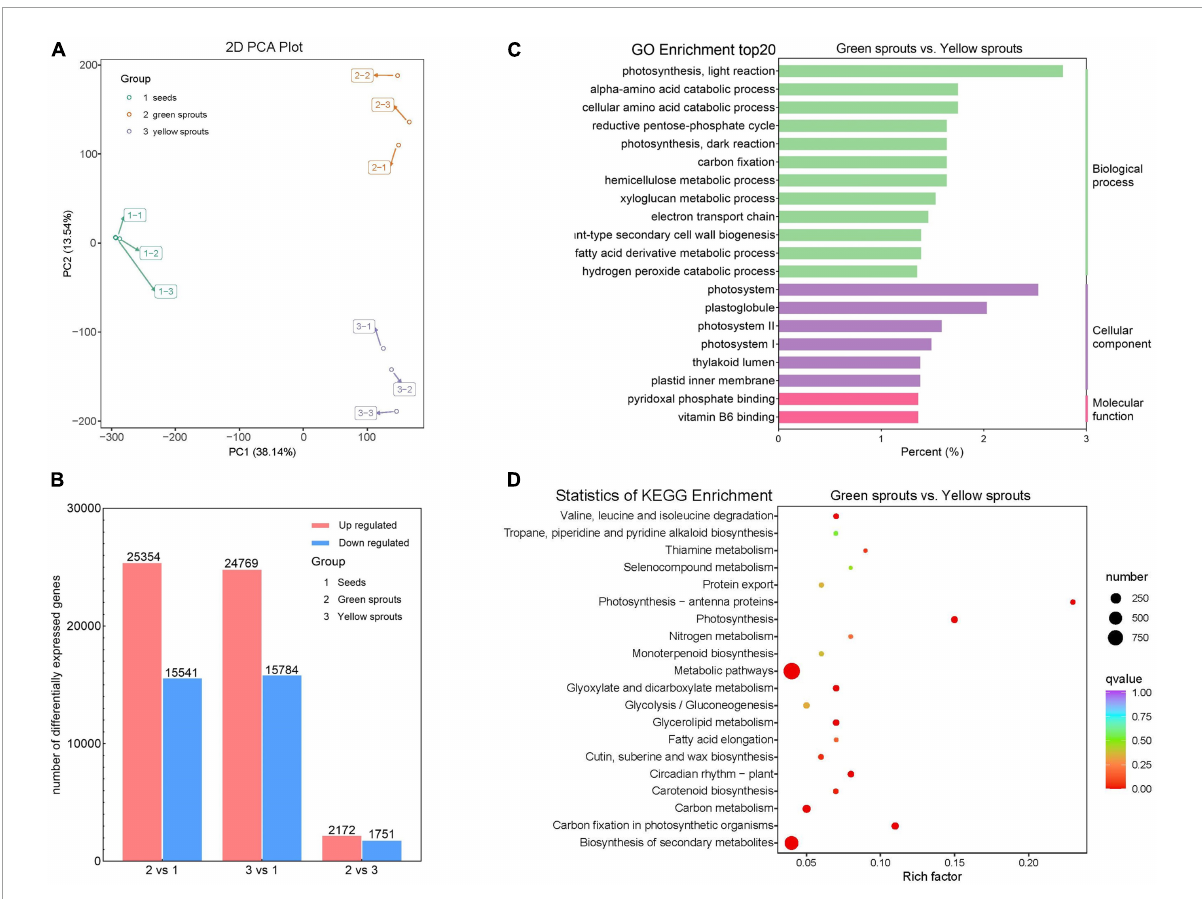
FIGURE2 Transcriptomic analysis of alfalfa sprouts. (A) PCA score plot of transcriptome profiles from different treatment groups (1: 12-h-soaked alfalfa seeds; 2: green alfalfa sprouts; 3: yellow alfalfa sprouts). (B) Numbers of DEGs in 2 vs. 1, 3 vs. 1, and 2 vs. 3. (C) GO functional classification of DEGs between green and yellow sprouts. (D) KEGG pathway enrichment of DEGs between green and yellow